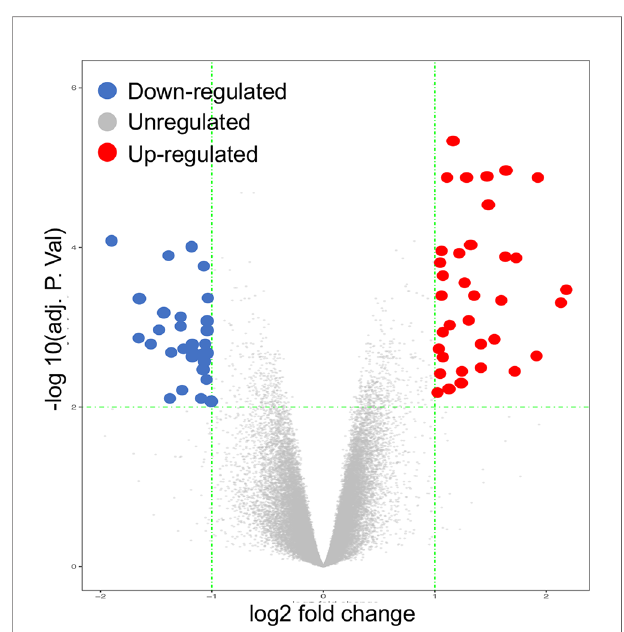
FIGURE 3 | Volcano Plot image displaying the 66 genes that were signi fi cantly up-regulated or down-regulated (P-value < 0.05) in OA cartilage, compared to normal